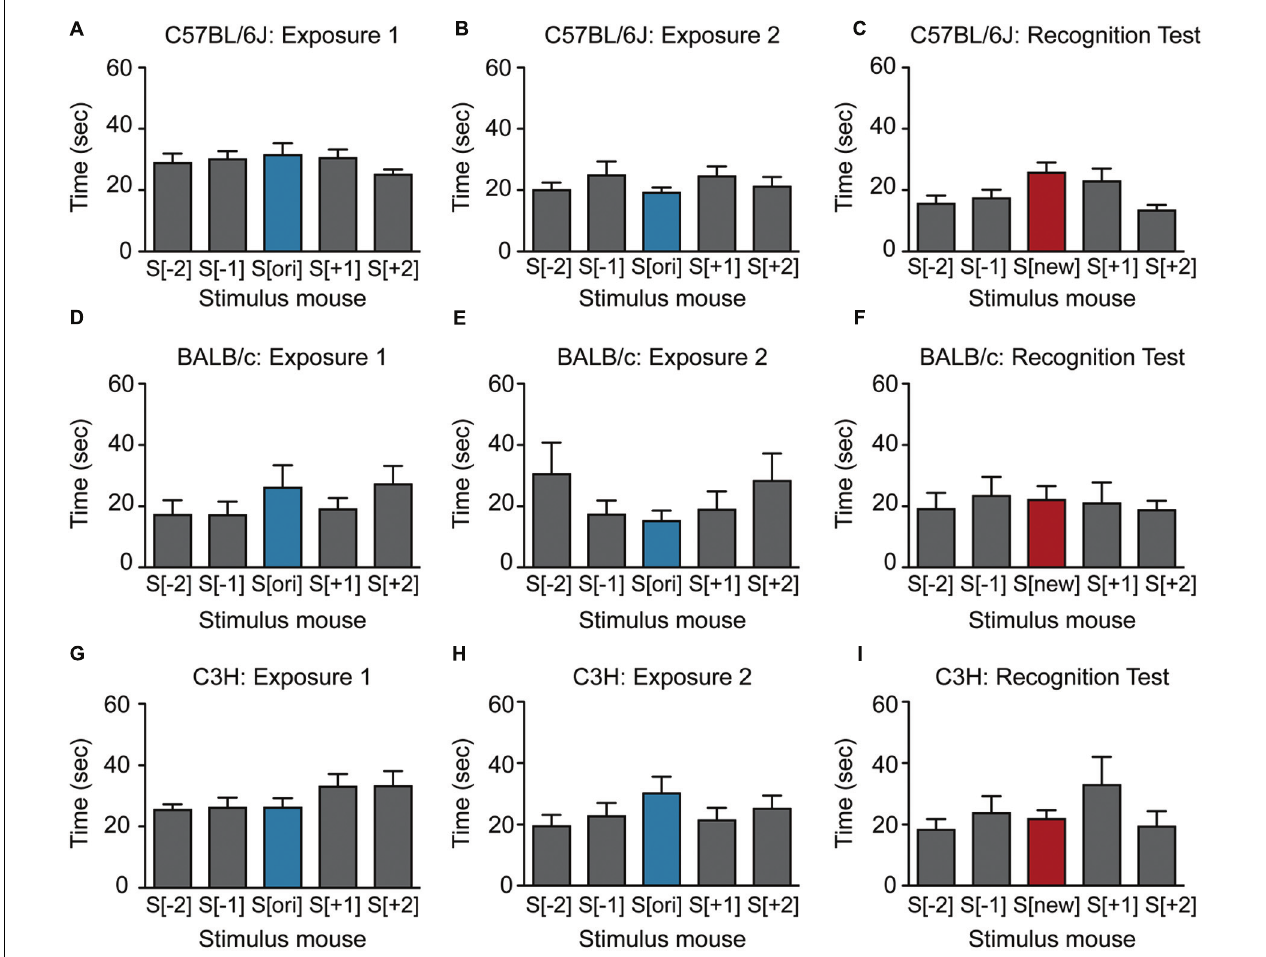
FIGURE 3 | Female mice show little or no social recognition in the SocioBox paradigm. (A–C) Interaction time of female C57BL/6J mice with each stimulus mouse during (A) exposure 1, (B) exposure 2, and (C) recognition test. (D–F) Interaction time of female BALB/c mice with each stimulus mouse during (D) exposure 1, (E) exposure 2, and (F) recognition test. (G–I) Interaction time of female C3H mice with each stimulus mouse during (G) exposure 1, (H) exposure 2, and (I) the recognition test. Statistical analysis was conducted using one-way ANOVA, summarized in Table 2 . Data are expressed as interaction time in sec (mean ±